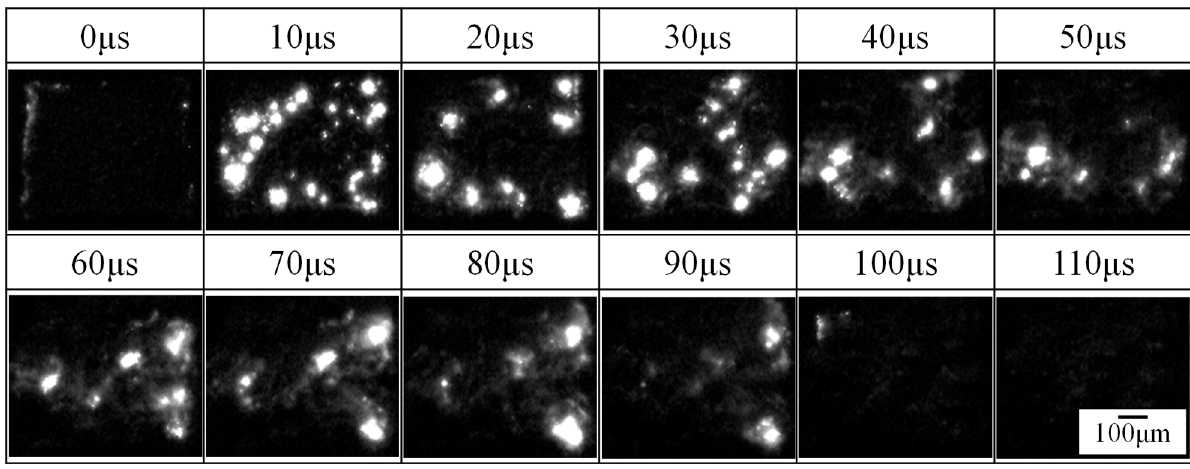
Figure 9. Behavior of micro-arcs in the front view during the PEO process by ST operation.